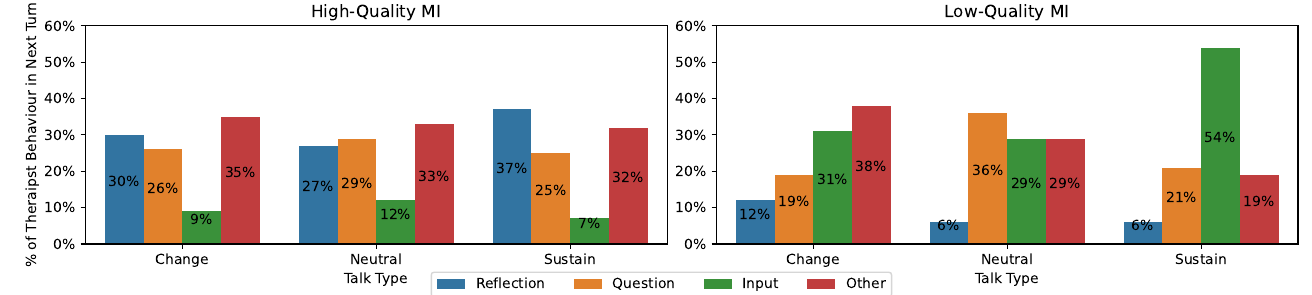
Figure 4. Distribution of next-turn therapist behaviours given different client talk types in the current